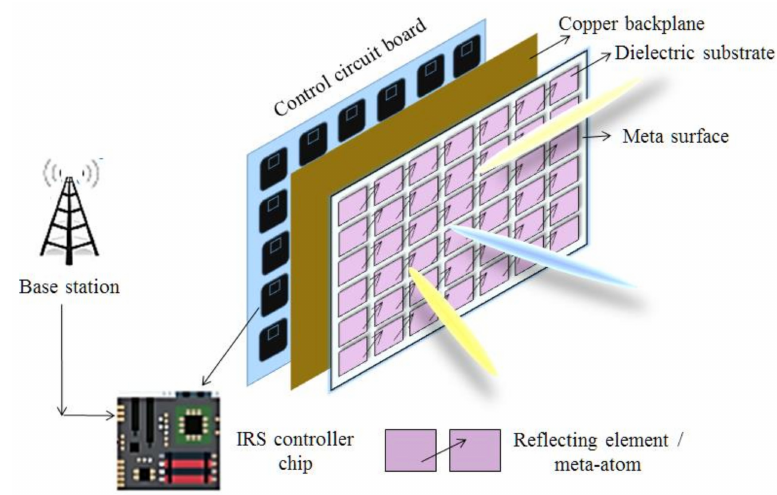
Figure 4. Basic hardware architecture of IRS.